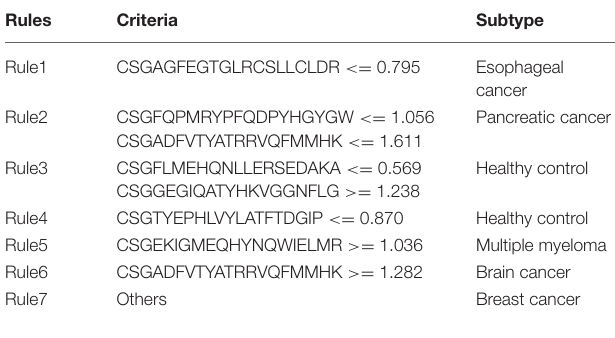
Frontiers in Bioengineering and Biotechnology |